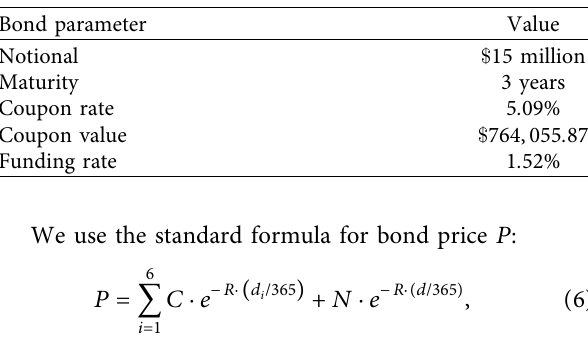
Table 6: Cyber bond